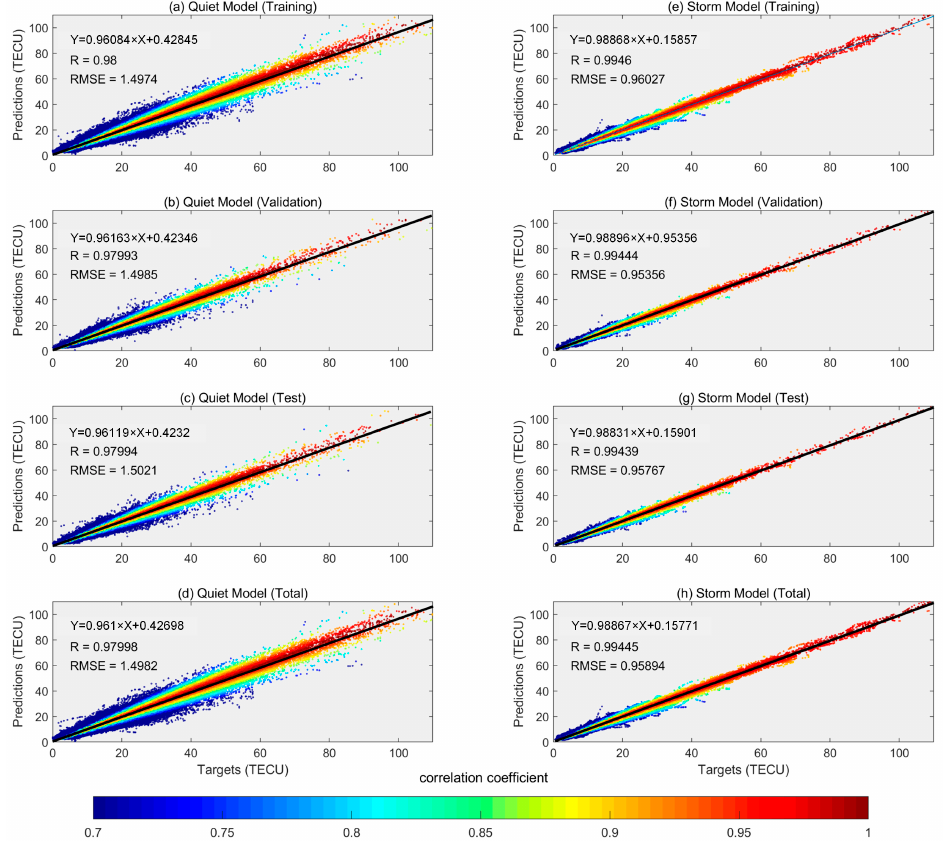
Figure 4. Prediction performances of the JIM model for different sample dataset under quiet and “Storm” space environments.